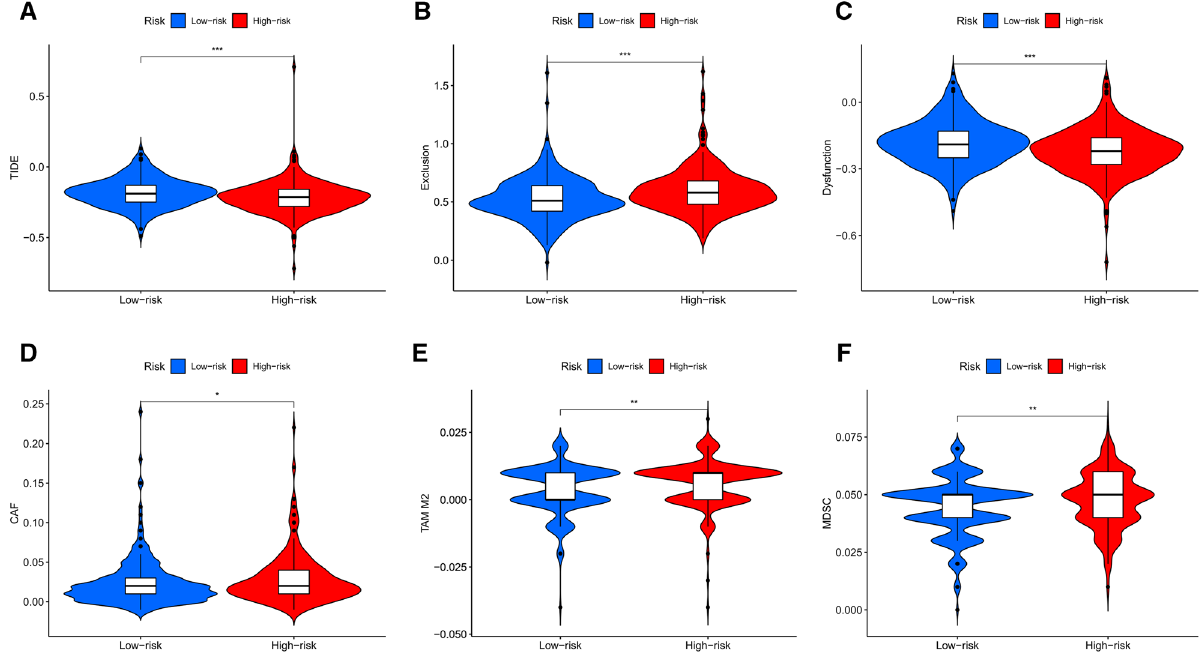
Figure 9. The correlation between the risk signature and T cell function. ( A ) Scores of TIDE, ( B ) T-cell exclusion and ( C ) dysfunction in different risk groups. ( D ) Infiltration level of CAF, ( E ) TAM M2, and ( F ) MDSC in different risk